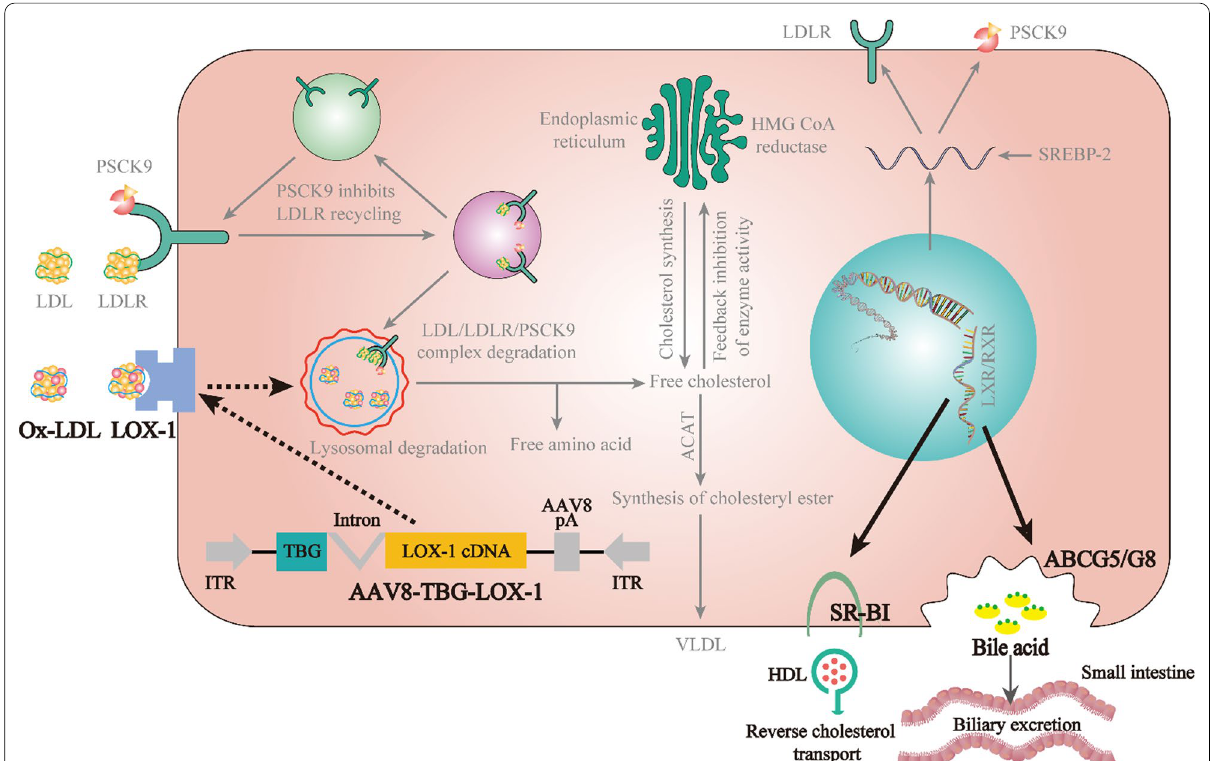
Fig. 8 Schematic diagram of the Ox-LDL uptake and lipid metabolism pathways of the hepatocytes. AAV8-TBG-LOX-1 induces hepatocyte-specific expression of LOX-1, and hepatocytes endocytose LDL and Ox-LDL via LDLR and LOX-1; LDL and Ox-LDL are then degraded into amino acids and free cholesterol by lysosomes. Free cholesterol can induce an increase in biliary cholesterol excretion in hepatocytes; furthermore, it can reduce cholesterol synthesis through feedback inhibition of hydroxymethylglutaryl coenzyme A (HMG-CoA) reductase. Hepatocytes can maintain stable lipid metabolism through other cholesterol metabolism pathways, such as the reverse cholesterol transport pathway. Note: The entire square region is a hepatocyte, and the nucleus (green sphere) is the centre of metabolic regulation. The nuclear transcription factor LXR/RXR located in the nucleus regulates the expression of the cholesterol transporters ABCG5 and ABCG8, which secrete cholesterol into the lumen of the small intestine (the lower right area in the figure) as bile acids. SREBP-2 (RNA helix-like icon in the upper right of the figure) transcribed into the cytoplasm through the nucleus regulates the dynamic equilibrium between LDLR and PCSK9. LDLR (green arc-shaped transmembrane receptor in the figure), located on the cell membrane surface, is responsible for the uptake and metabolism of circulating LDL (near the cell membrane and cytoplasmic molecules and organelles in the upper left of the figure), and the ability of LDLR to recycle to the cell membrane after binding LDL and internalizing into hepatocytes is closely related to the regulation of PCSK9 (the red icon in the upper right of the figure). HDL-C is taken up through SR-BI (light green receptor with corresponding green spherical HDL icon in the lower right of the figure) on the surface of hepatocytes. In the endoplasmic reticulum (green reticular membrane icon in the cytoplasm in the middle-upper portion of the figure), HMG-CoA reductase synthesizes cholesterol, of which some is packaged into VLDL and secreted into the blood and some is stored after ACAT